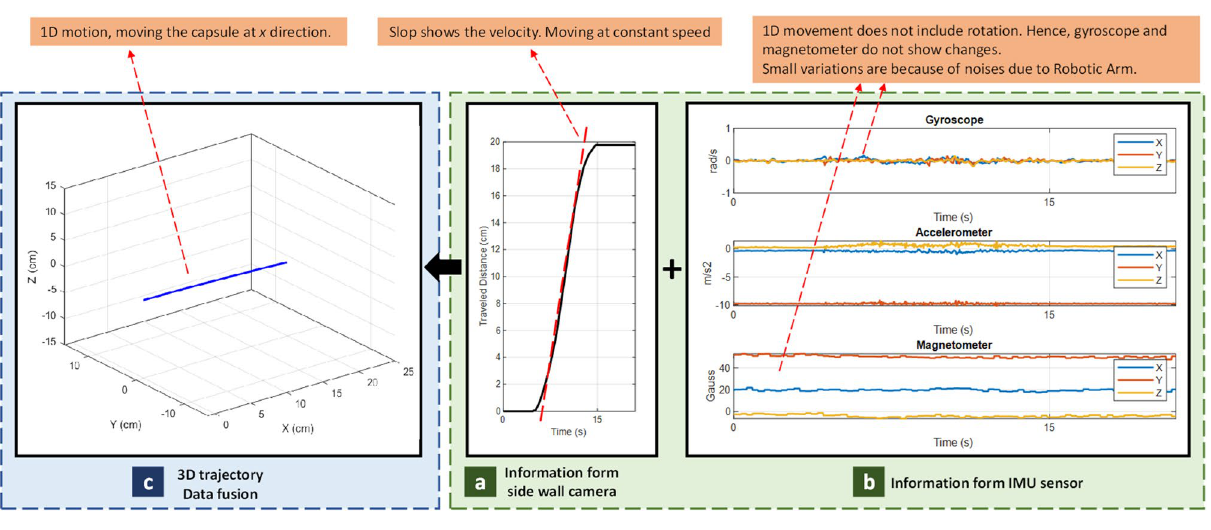
Figure 9. Results of 1D